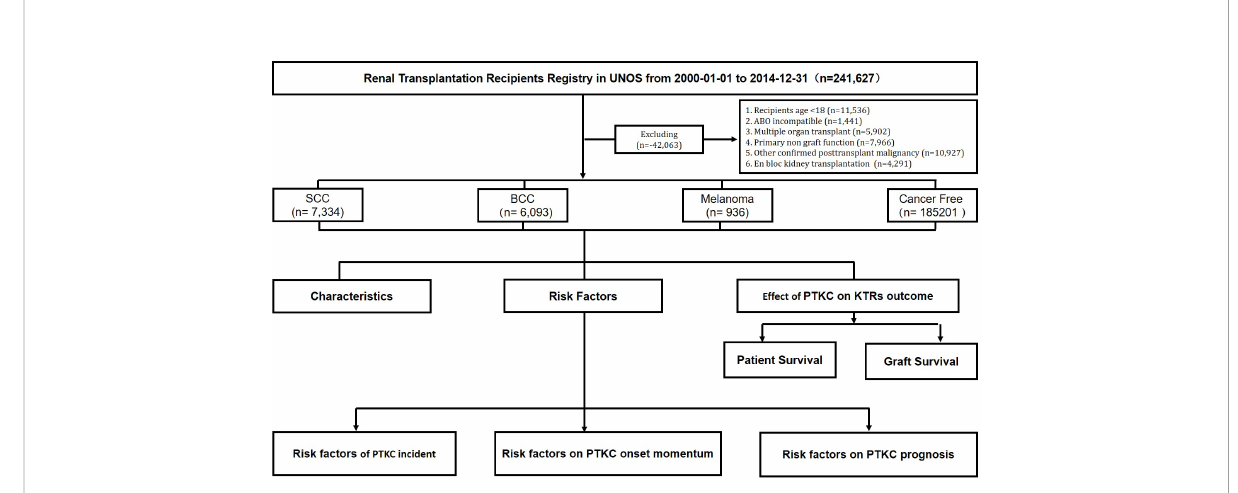
FIGURE 1 Flowchart of study cohort identi fi cation. SCC, squamous cell carcinoma; BCC, basal cell carcinoma. All kidney transplant recipients from 1 January 2000 to 31 December 2014 were followed from the date of transplantation to the date of outcome, censored for loss to follow-up, or end of the study